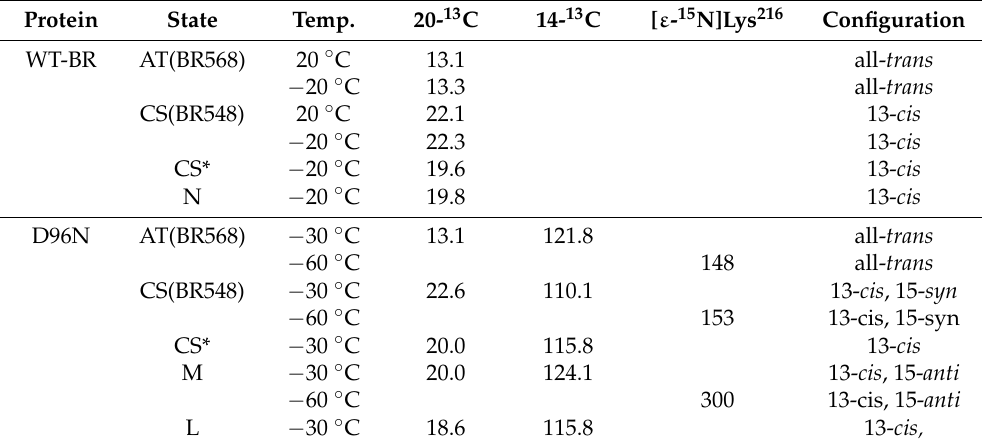
CS*: State of intermediate that is transformed from CS state under green light